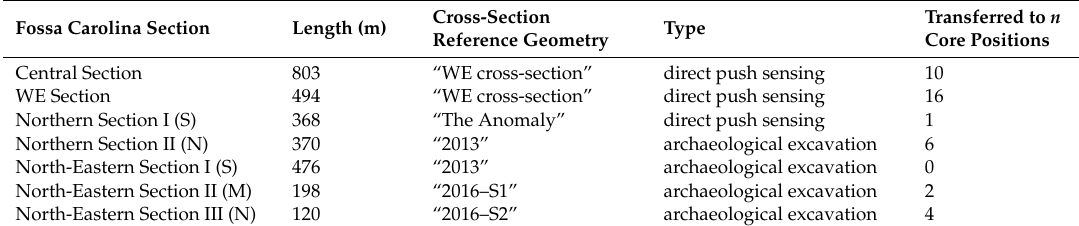
Table 2. Sections of the Fossa Carolina and corresponding cross-sections reference